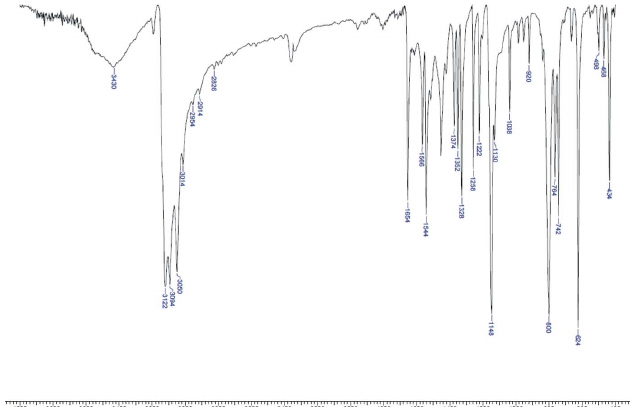
Figure 5 FT–IR spectrum of [ L ] 2 [MnCl 4 ] ( I ) in KBr in the 4000–400 cm (cid:5) 1